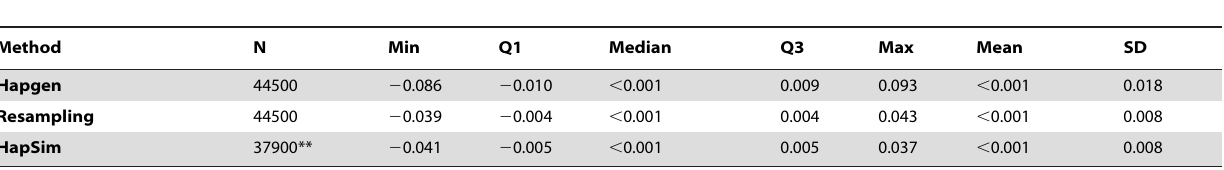
Table 2. MAF–Gene Region